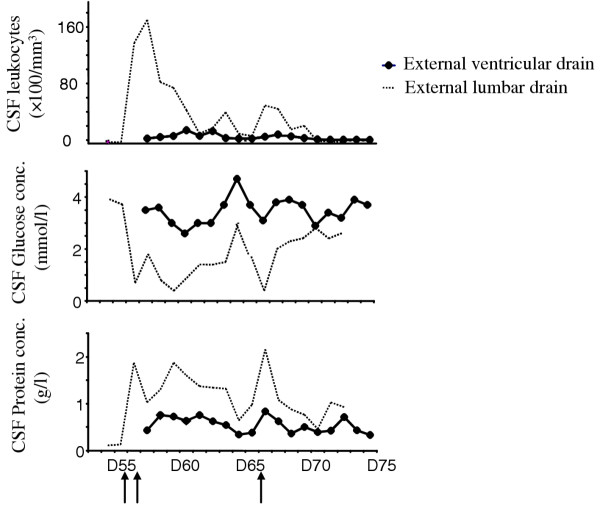
Time course of the ventricular-to-lumbar gradient of cerebrospinal fluid leukocyte, glucose and protein concentrations in cerebrospinal fluid. The arrows represent days of positive cerebrospinal fluid culture.